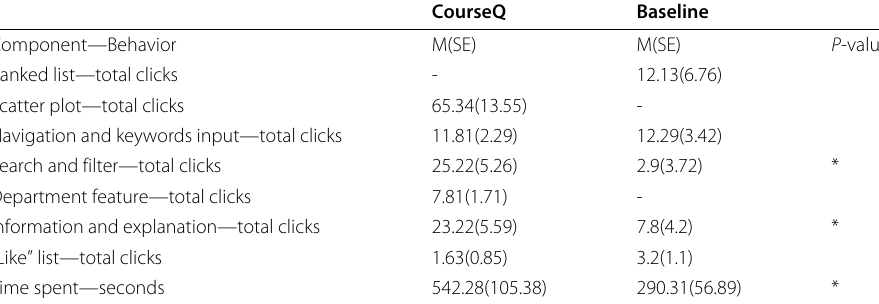
Table 1 User interaction statistics (Significance level: (*)